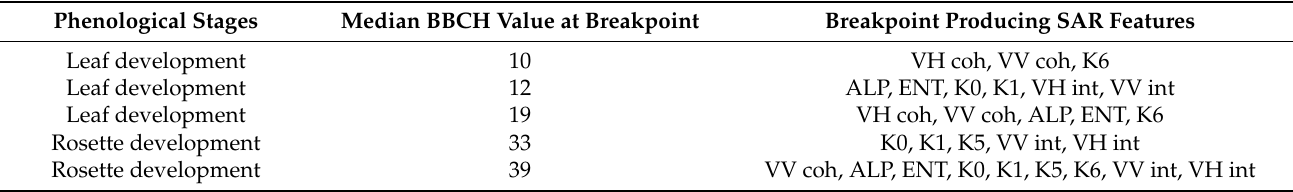
development (BBCH: 10) was indicated by VV and VH coherence as well as K6, leaf devel- opment (BBCH: 12) by Alpha and Entropy, K0, K1, VH, and VV backscatter. The later leaf development (BBCH: 19) was found in signatures of both coherences, Alpha and Entropy, plus K6. The earlier stage of rosette development (BBCH: 33) produced a breakpoint in was indicated by every feature except the VH coherence. Table 7. Median BBCH values and phenological stages of breakpoints derived from corresponding SAR features in sugar beet fields.